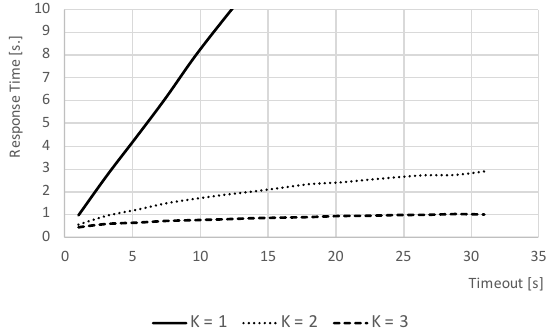
Figure 5. Behavior of Response Time for timeout ranging from 1 to 30 s, λ = 0.9 r/s for a variable number K of VMs.